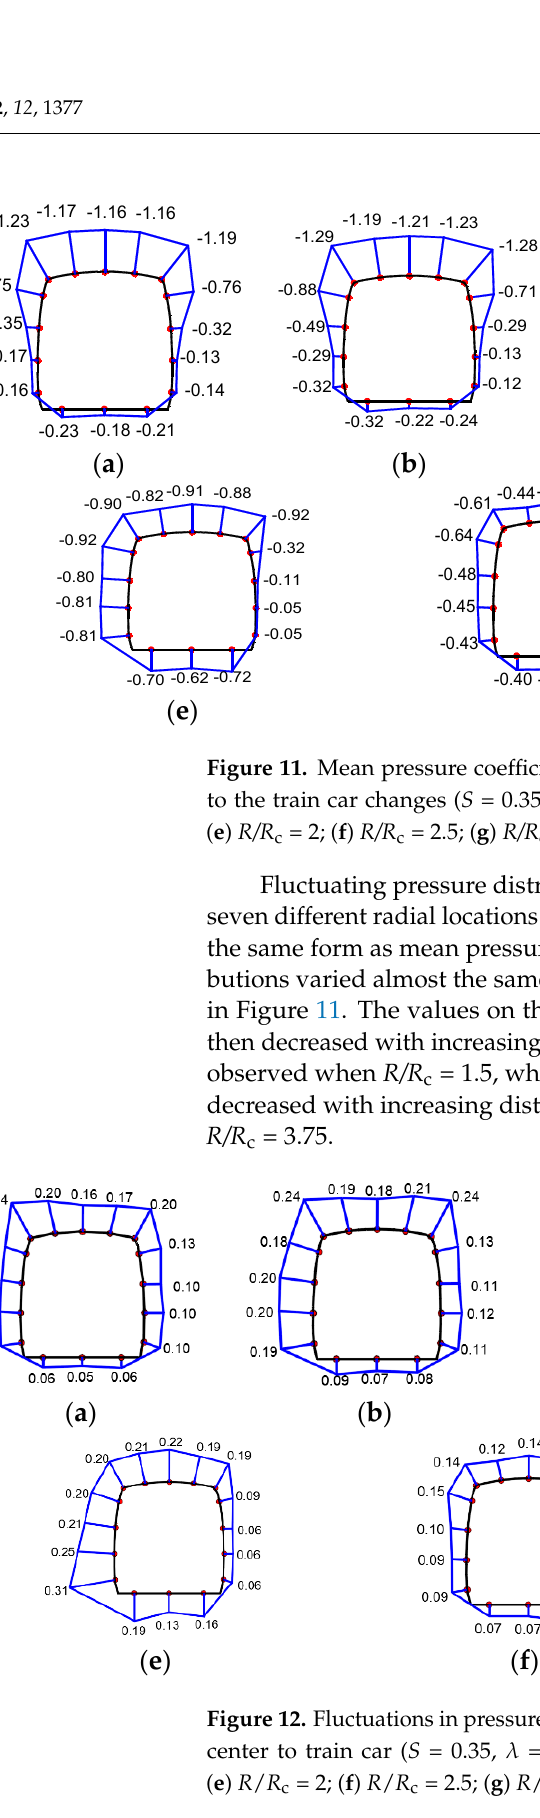
Figure 11. Mean pressure coefficients at the middle section as distance from the tornado’s center to the train car changes ( S = 0.35, λ = 0). ( a ) R/R c = 0; ( b ) R/R c = 0.5; ( c ) R/R c = 1; ( d ) R/R c = 1.5; ( e ) R/R c = 2; ( f ) R/R c = 2.5; ( g ) R/R c = 3.75.